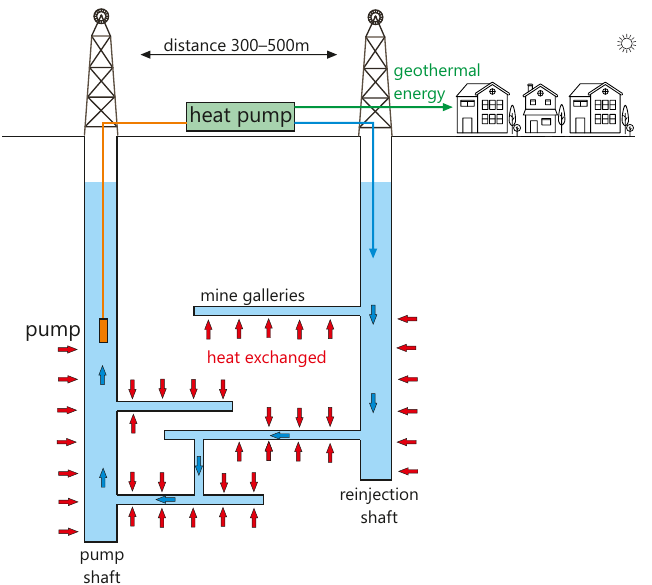
Figure 7. Heat extraction from abandoned flooded mine using open loop with reinjection.